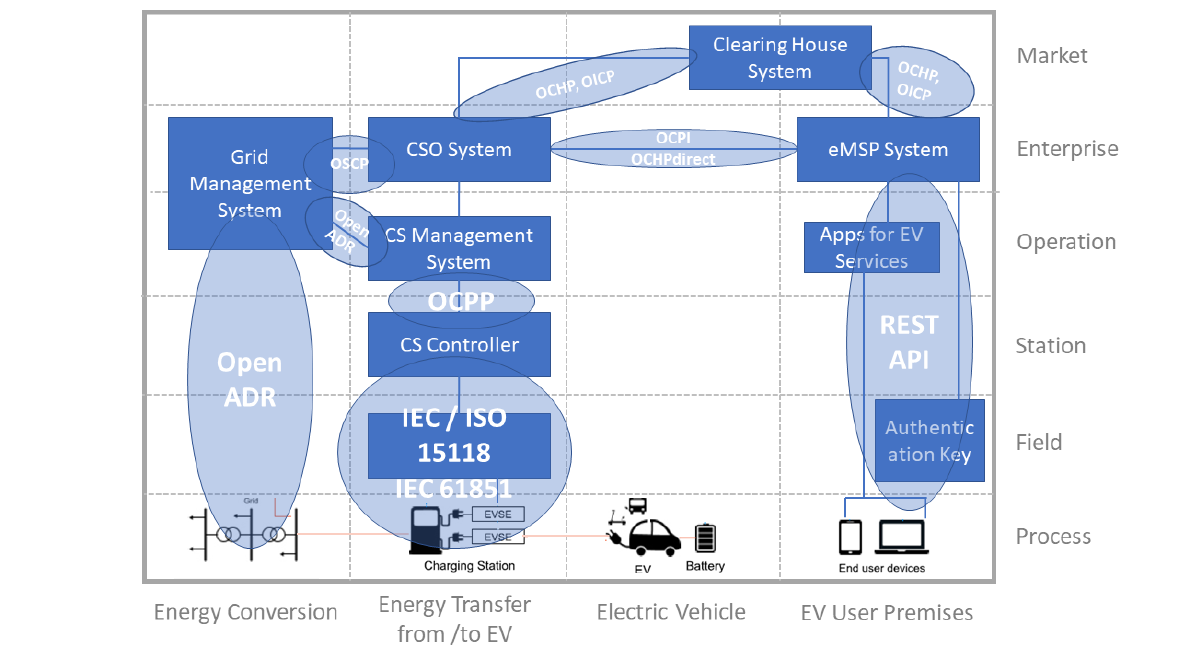
Figure 3. The most dominant standard data formats used for information exchange between pairs of actors/stakeholders involved in electric mobility cyber physical systems inspired by